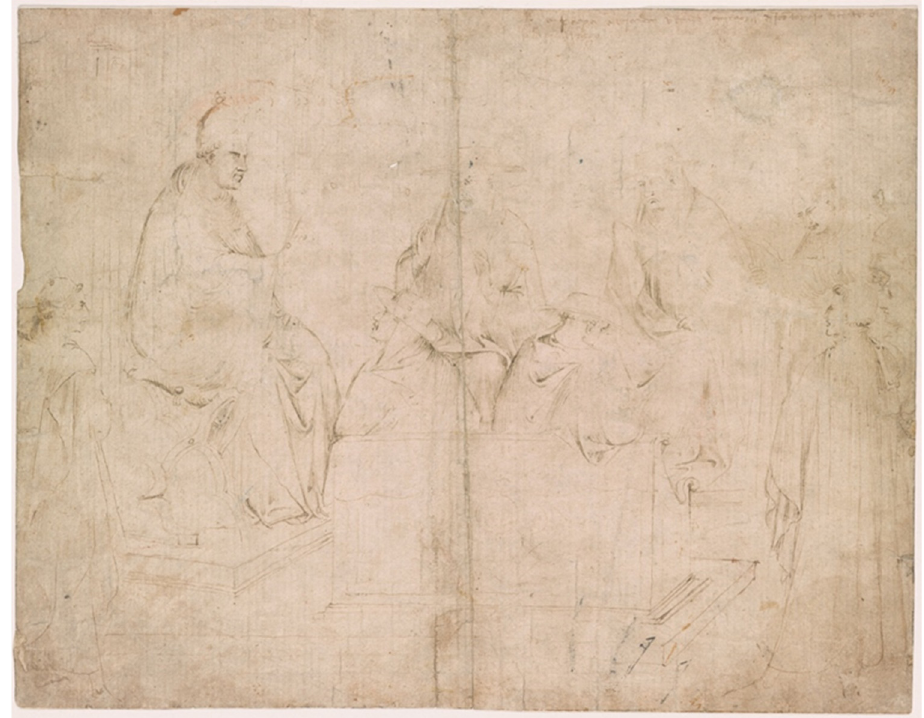
Figure 6. Spinello Aretino, Pope Alexander III in Council (Canonization of Thomas Becket) , 1407–1408, pen and brown ink, 282 × 361 mm, The Morgan Library & Museum, New York (photo: The Morgan Library & Museum, New York).